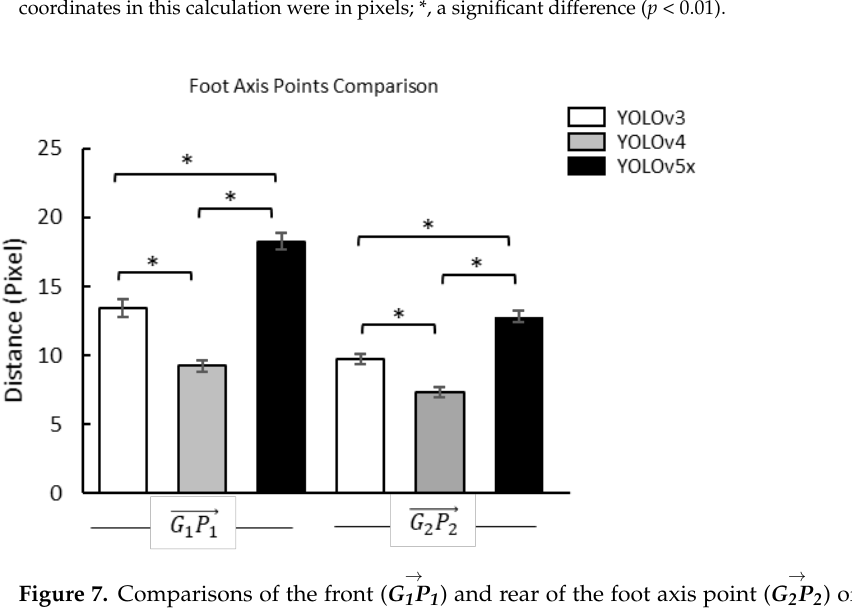
Figure 8. Comparisons of the effect of different YOLO models on the distances between the ground- truth point and prediction point at the front point of the angle-box ( 𝑮 𝟏 𝑷 𝟏 ⃗⃗⃗⃗⃗⃗⃗⃗⃗⃗ ), and rear points of the angle-box ( 𝑮 𝟐 𝑷 𝟐 ⃗⃗⃗⃗⃗⃗⃗⃗⃗⃗ ). *, a significant difference ( p < 0.01).